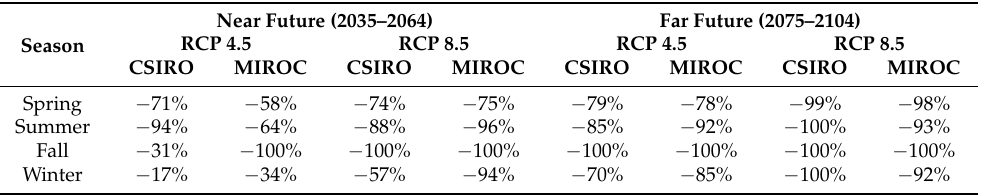
Table 7. Seasonal streamflow changes in future with reference to observed